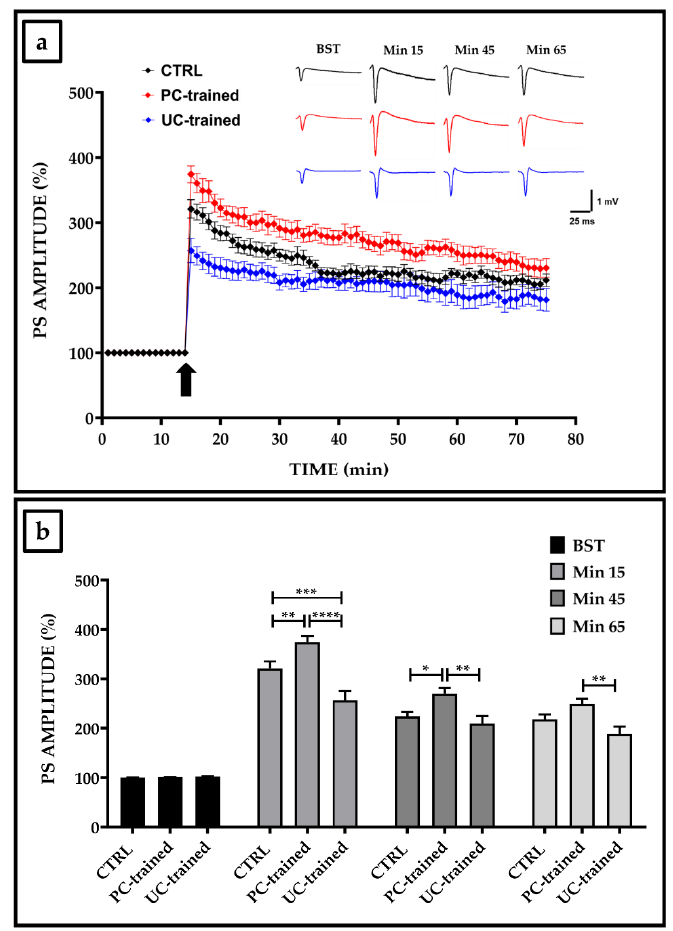
Figure 1. Synaptic plasticity in the CA1 hippocampal subfield of trained and sedentary mice. ( a ) Percentage population spike (PS) amplitude as a function of time after high-frequency stimulation (HFS), applied at time t = 15 (arrow), is shown in CTRL (black line, n = 15), in PC-trained (red line, n = 9), and in UC-trained (blue line, n = 8) mice slices. The insert shows representative recordings obtained from slices of each experimental group. The first curve of each group refers to the basal synaptic transmission (BST) and it was recorded before the HFS application, whereas the other curves refer to PS at times 15, 45 and 65 min after the HFS. ( b ) The PS amplitude values of BST, at min 15 (immediately after HFS), at min 45 and at min 65 from the HFS, are shown for each experimental group. Bars in the plot are means ± SEM of values obtained from different slices. Note that a significant statistical difference was reported between trained and control groups at min 15 (CTRL vs. PC-trained, ** p < 0.01; CTRL vs. UC-trained, *** p < 0.001; PC-trained vs. UC-trained, **** p < 0.0001), at min 45 (CTRL vs. PC-trained, * p < 0.05; PC-trained vs. UC-trained, ** p < 0.01) and at min 65 (PC-trained vs. UC-trained, ** p <